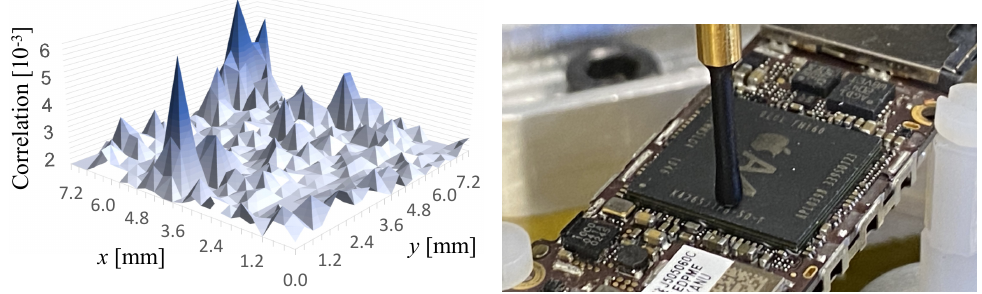
Figure 7: 3D heatmap of the SoC plotting highest correlation in time using the selected HD power model and 150,000 traces at each spot (left) and probe position